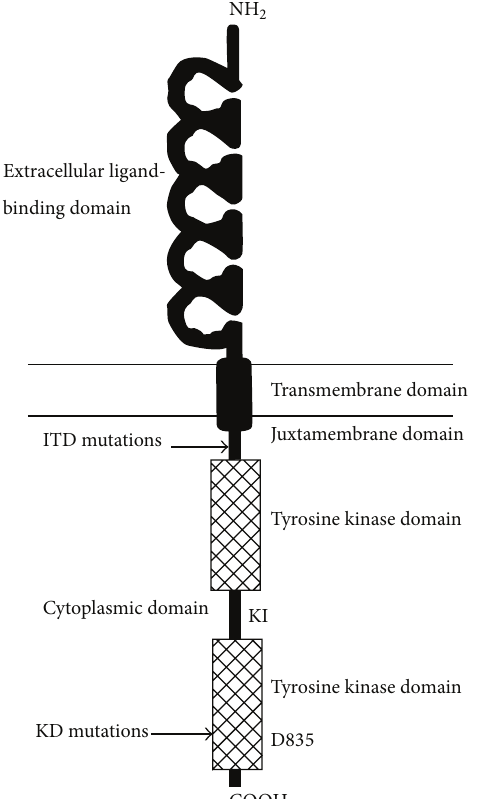
Figure 1: Diagram of FLT3 structure. Shown in schematic fashion are the 5 immunoglobulin-like folds that make up the ligand- binding extracellular domain, single transmembrane domain, and cytoplasmic domain made up of a kinase domain interrupted by a kinase insert. The juxtamembrane domain where internal tandem duplications (ITDs) occur and aspartic acid 835 where most kinase domain mutations occur are indicated by arrows (Small D. FLT3 Mutations: Biology and Treatment. Hematology Am Soc Hematol Educ Program.